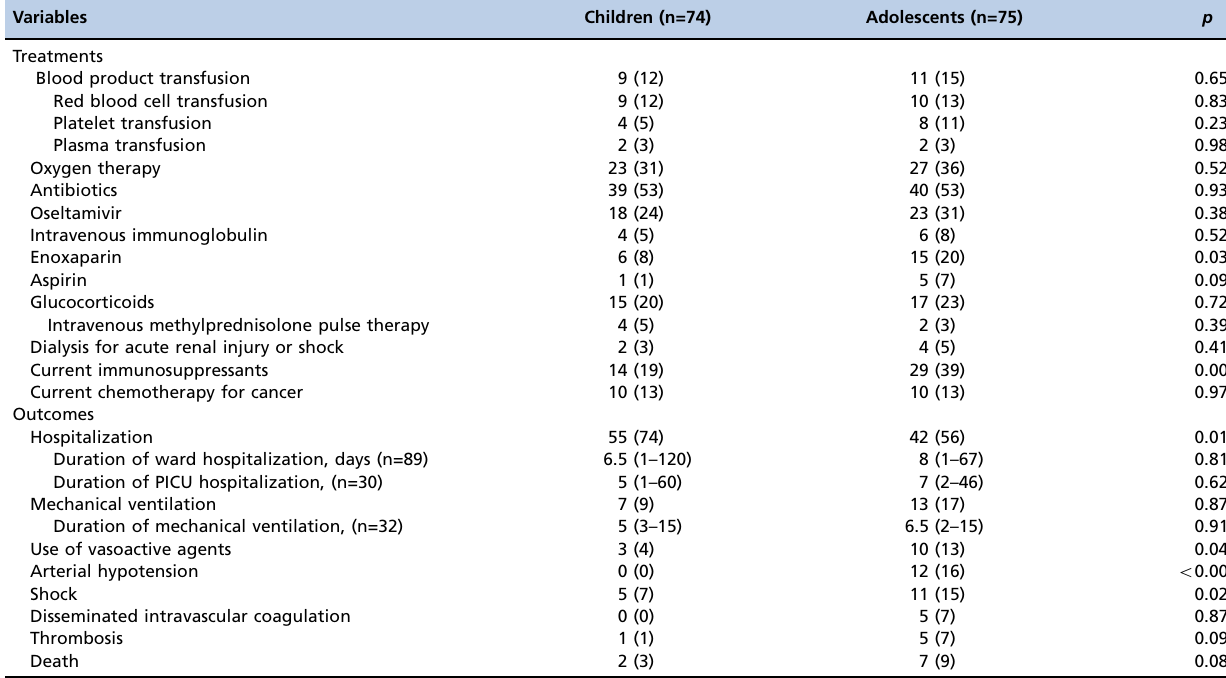
Table 3 - Treatments and outcomes in children (aged o 10 years) vs. those in adolescents (aged X 10 years) with laboratory-confirmed coronavirus disease 2019 (COVID-19). Variables